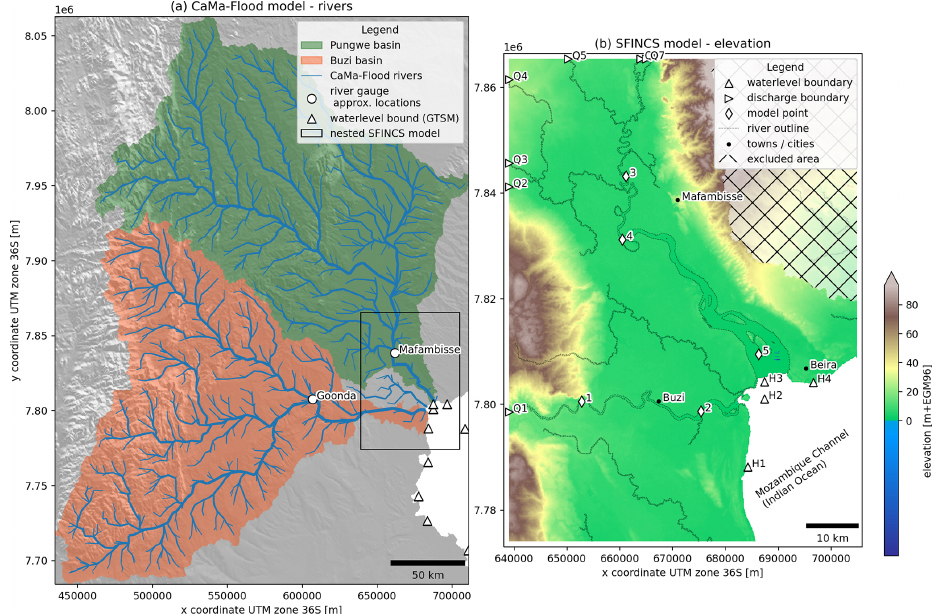
Figure 2. Maps of a regional cutout of the global CaMa-Flood model (a) and the local SFINCS model with boundary conditions and model output point locations for the case study in Sofala province, Mozambique (b) . Note that both maps are in different projections based on the projection used for the model schematization.